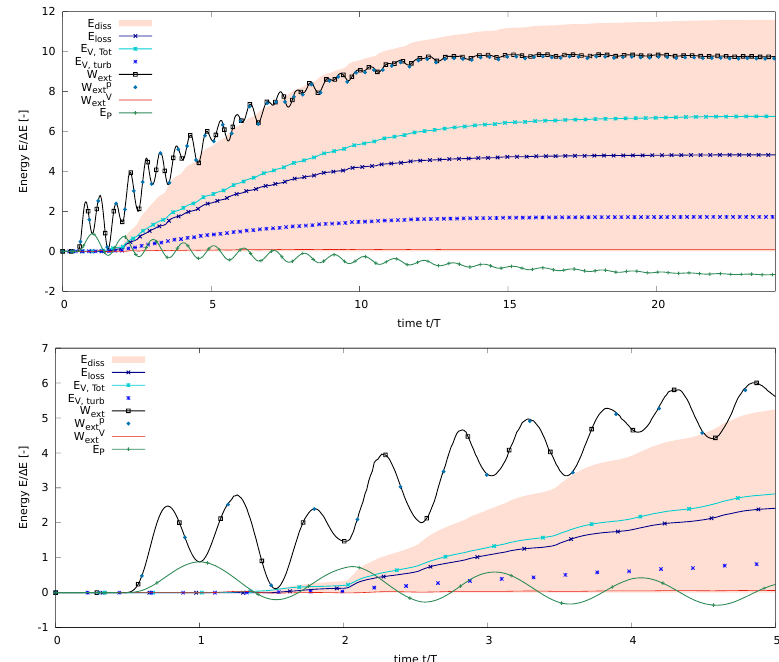
Figure 19. Oil energy distribution for one of the N 200 runs.